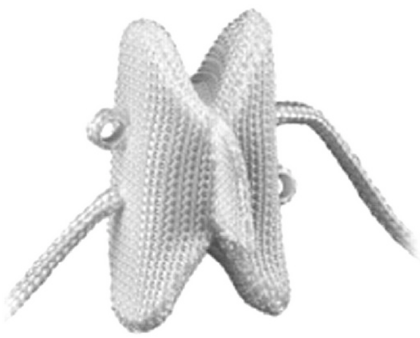
Figure 5: The DIAM interspinous spacer. each spinous process and one around the supraspinous